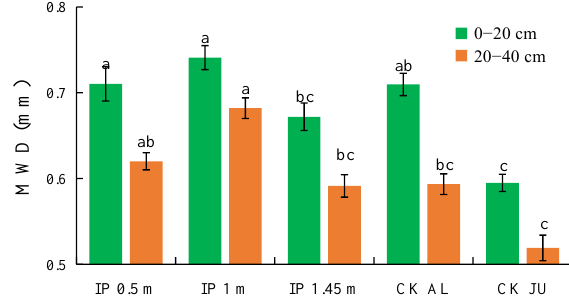
Figure 5. Mean weight diameter (MWD) of soil mechanically stable aggregates. The letters on the bar denote the significant differences between the treatments across the two soil depths.